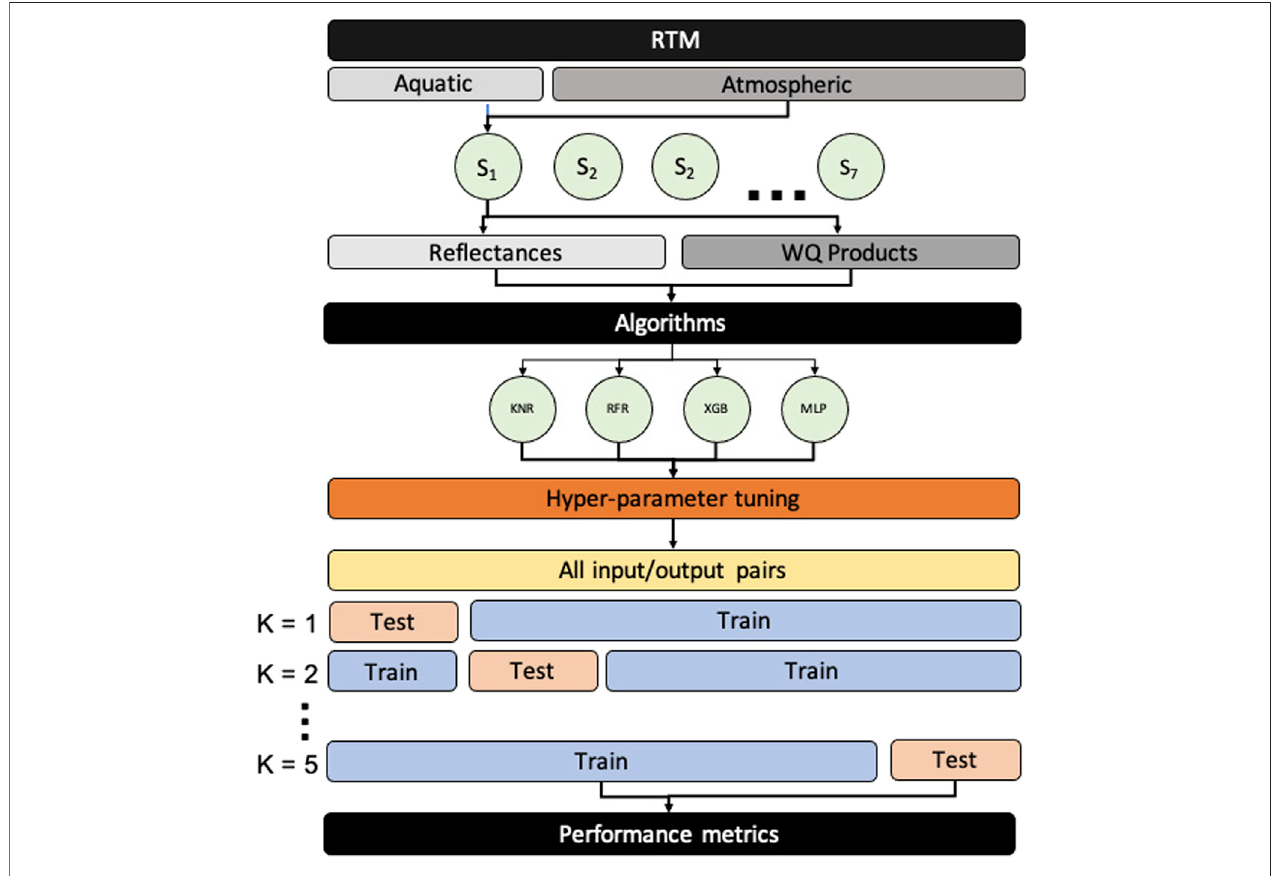
FIGURE 4 | A technical fl owchart showing the summarized data development and training stages of ML algorithms to retrieve water quality products ( “ WQ Products ” ). S x indicates one of the seven band con fi gurations used in data preparation. K represents the speci fi c iteration of k-fold cross validation.